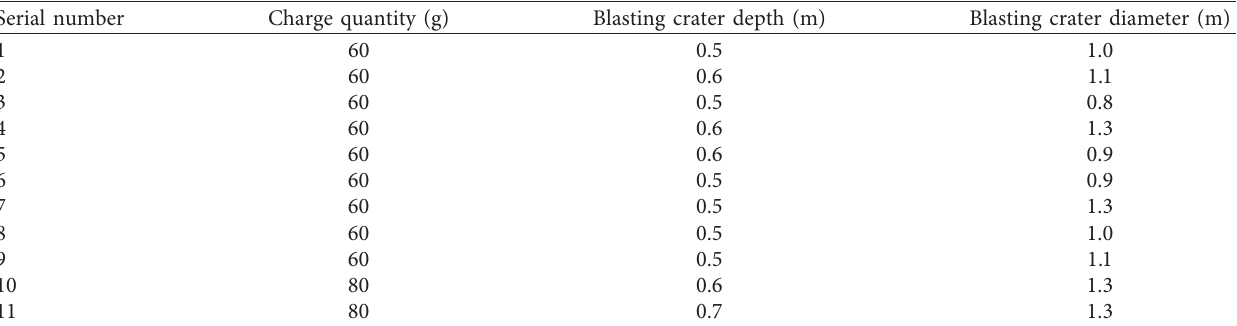
Figure 16: Blasting effect of field test: (a) 60g and (b) Table 5: Field test data of charge quantity in single blast hole.